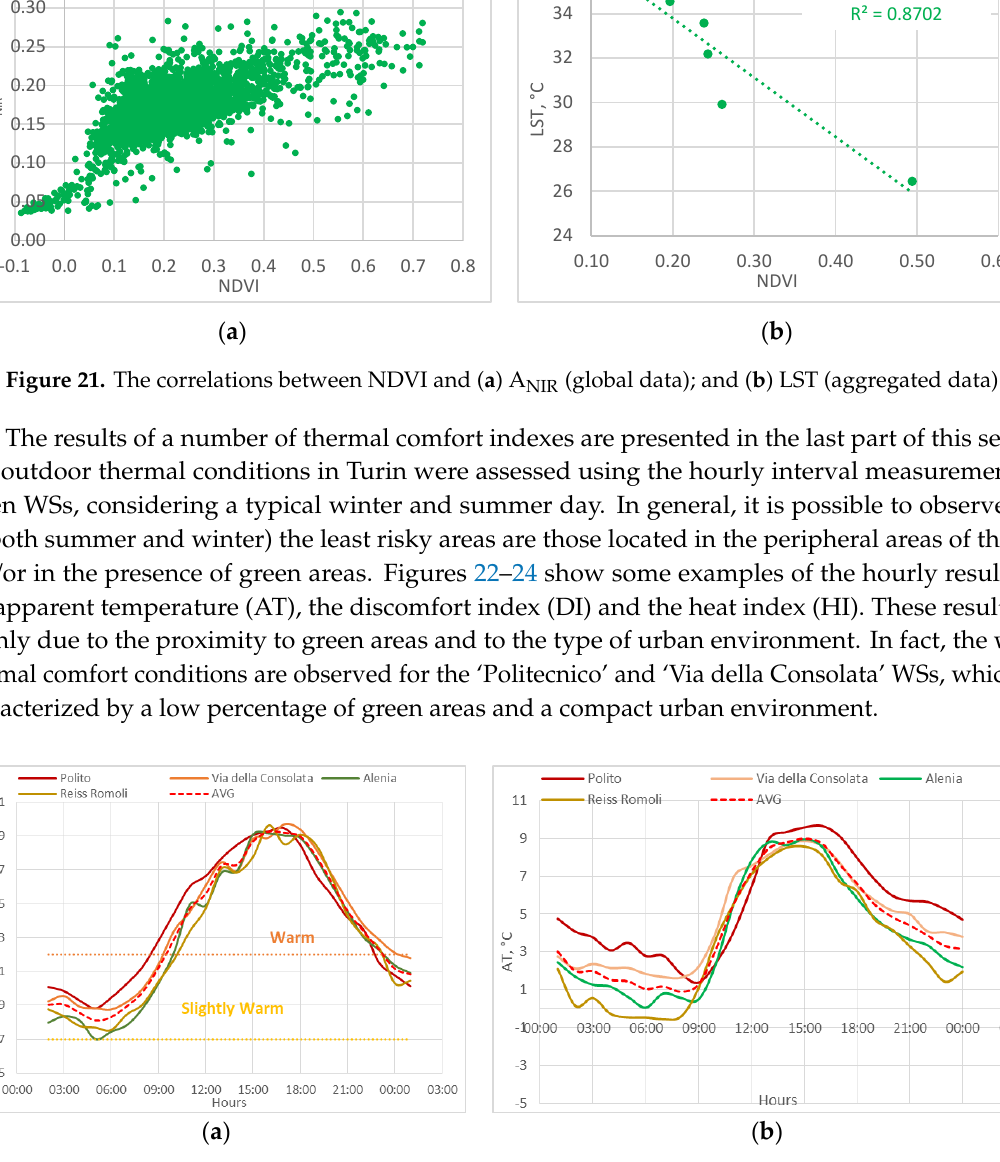
Figure 20. Aggregated data: correlations between LST and ( a ) BCR; ( b ) H/W.